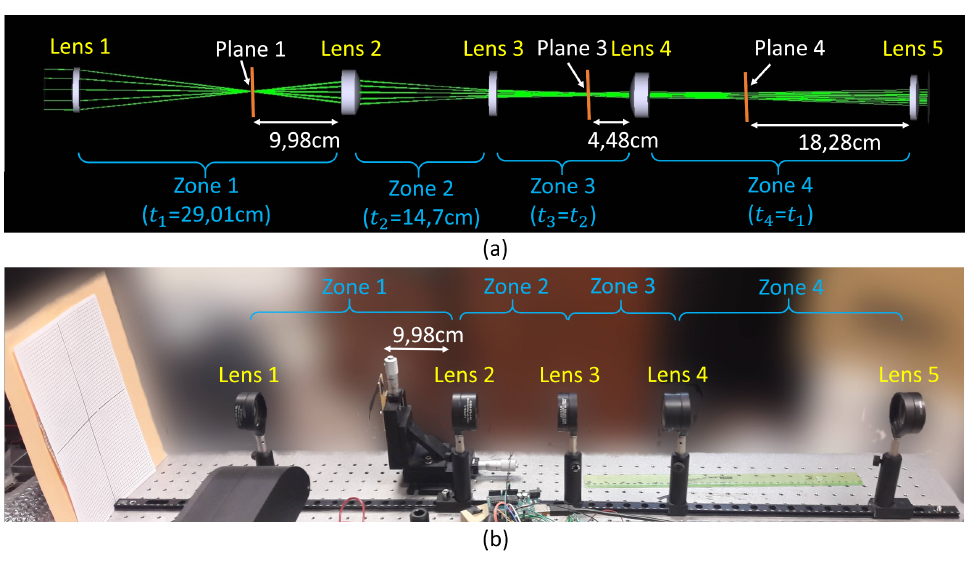
Figure 3. Case with f 3 = − 150 mm. ( a ) Scheme of the ray tracing of the considered system, including the distances between the lenses and the relative position of the invisible planes. ( b ) Picture of the experimental system for the case f 3 = − 150